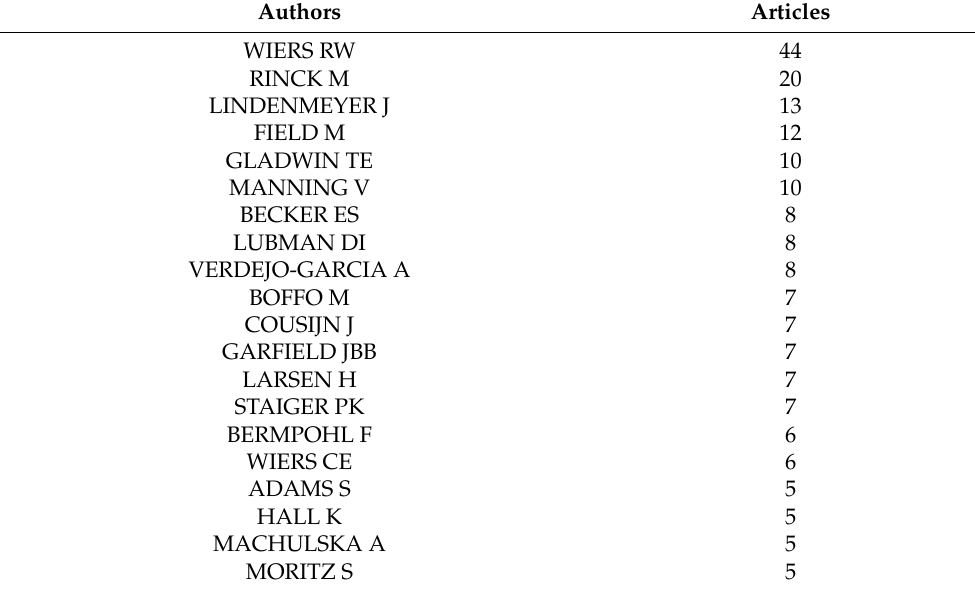
Table 2. Leading authors in the